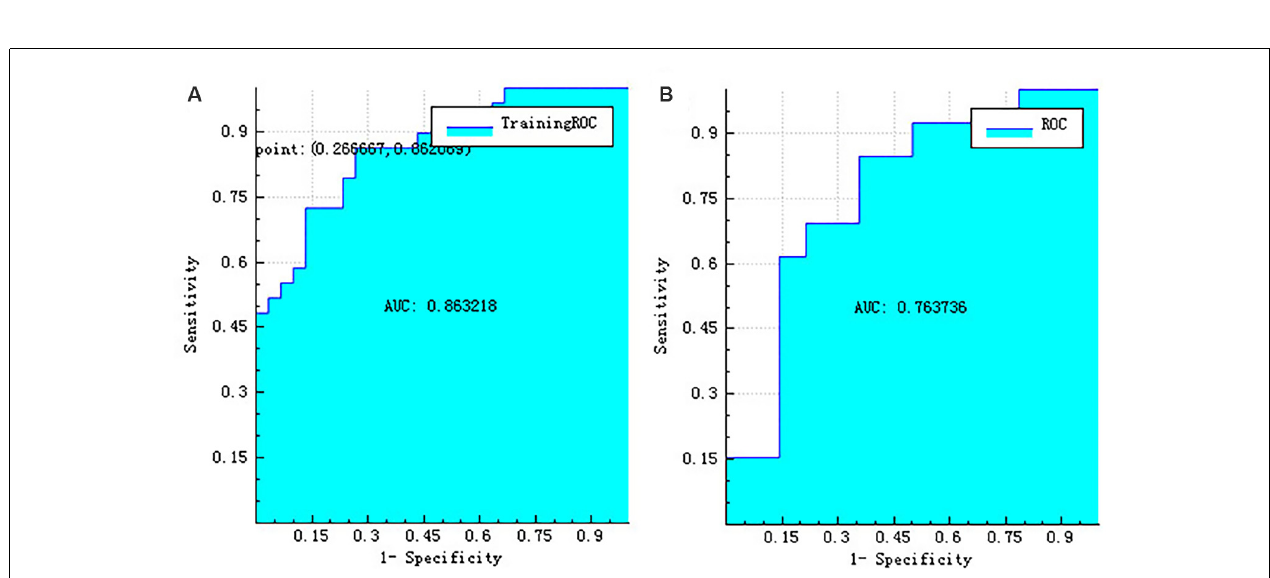
FIGURE 6 | The ROC curve of training data (A) and the ROC curve of testing data (B) of the right hippocampus. ROC, receiver operating characteristic.